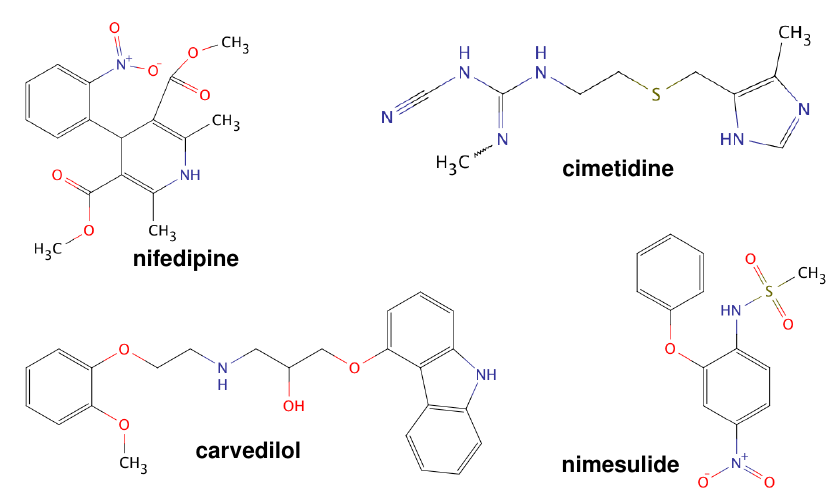
Figure 1. Chemical structures of carvedilol (CAR), cimetidine (CIM), nifedipine (NIF) and nimesulide